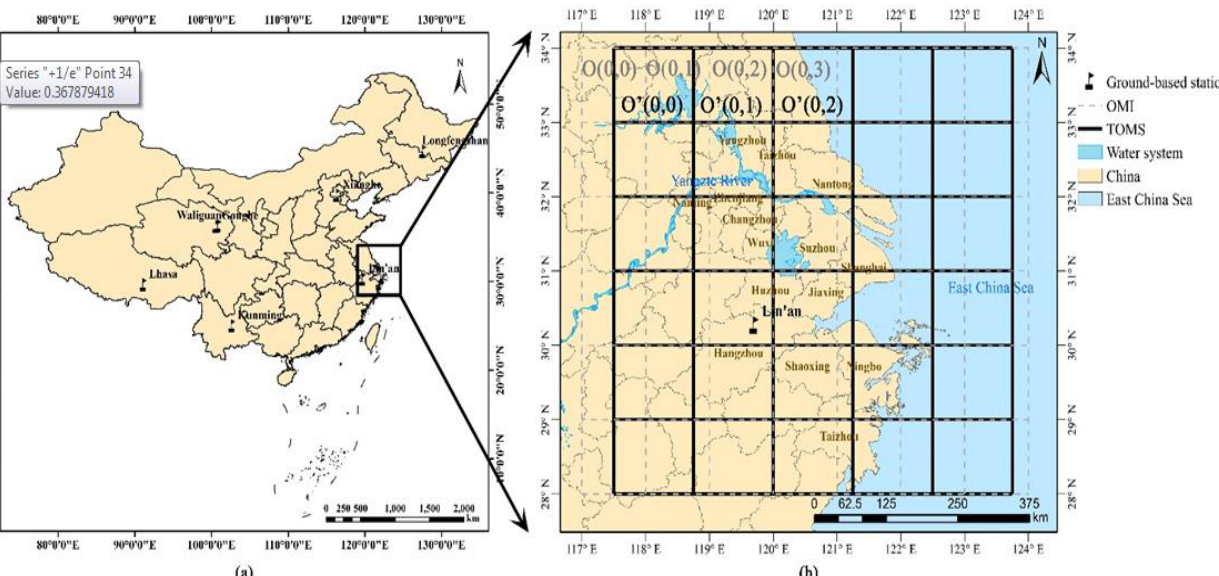
Figure 1. ( a ) Geographic location of ground-based stations in China and ( b ) the location of Yangtze River Delta and the grid of TOMS TOC data (30 black cells, each of 1.25° × 1°) and OMI TOC data (42 gray cells, each of 1° ×